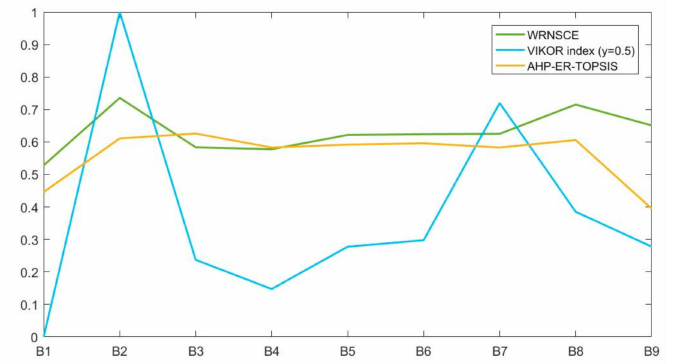
Figure 4. Comparison of WRNSCE, the VIKOR index and the AHP-evidential reasoning-TOPSIS approach.